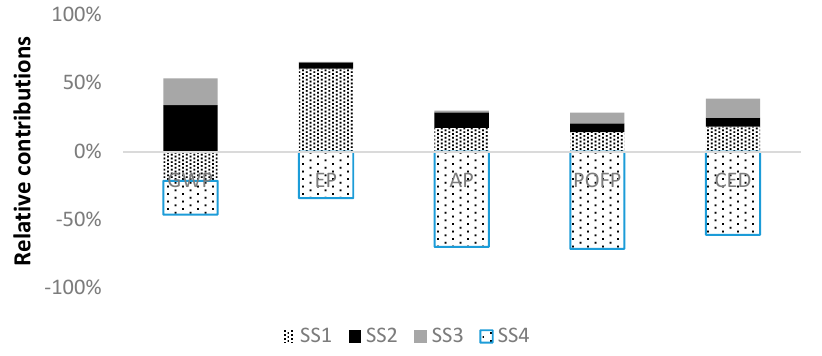
Figure 4. Relative contributions from subsystems involved to each impact category.